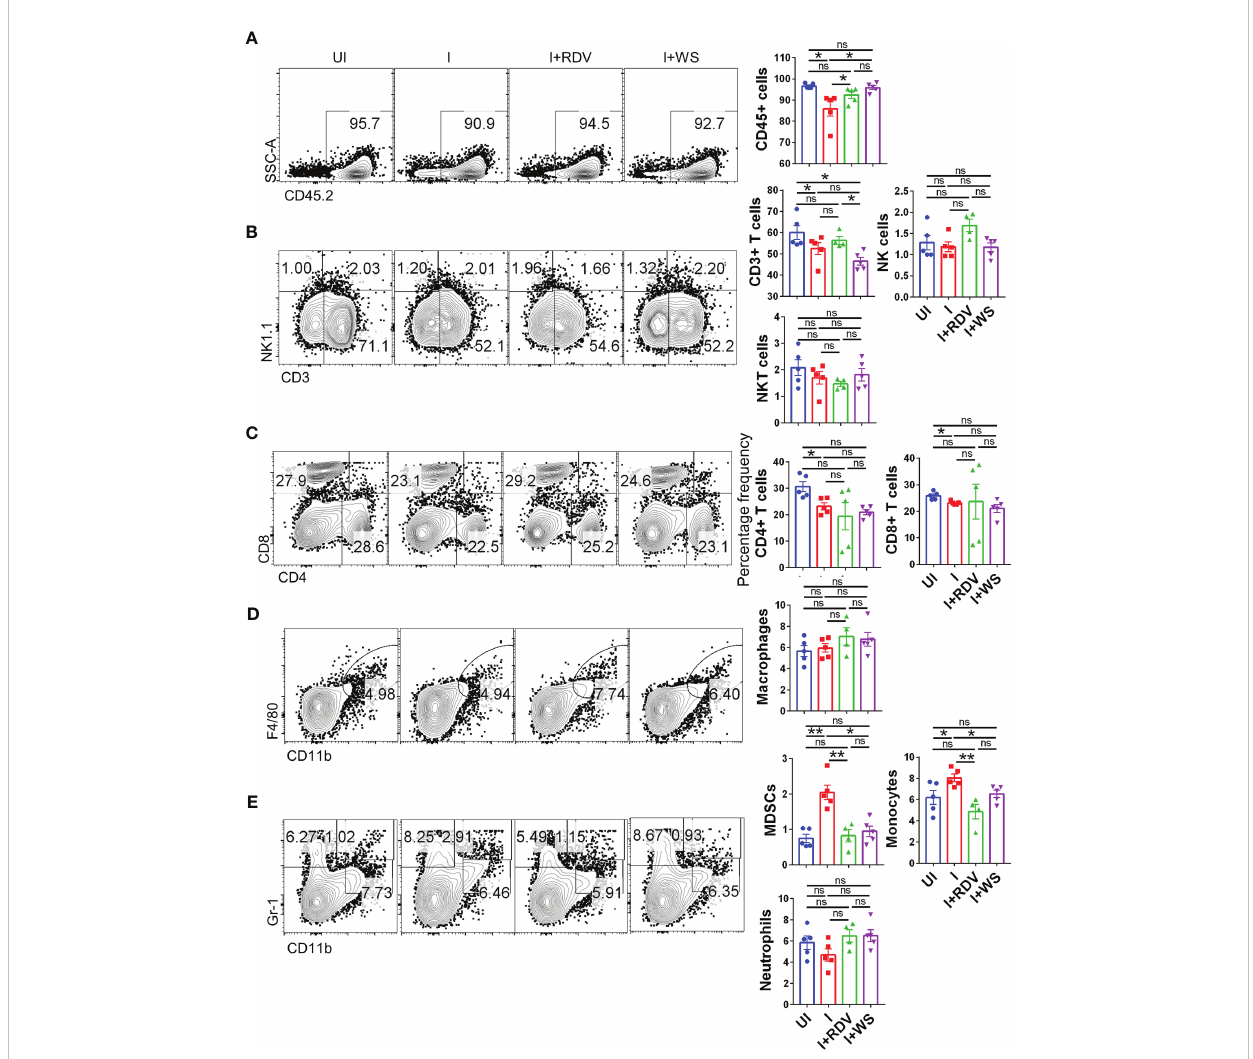
FIGURE 7 Changes in the major immune populations of infected hACE2 mice with or without treatment. Flow cytometry-based quantitation was done to evaluate changes in the major immune population in the lymph nodes of sacri fi ced animals at 6 dpi. The % age frequency was plotted as bar graph along with the representative contour plot (A) CD45+ population (B) CD3+ T lymphocytes, NK cells and NKT cells (C) CD4+ T helper cells and CD8 + T cytotoxic cells (D) Macrophages (E) Monocytes, neutrophils and MDSCs population. For each experiment N=5. One way-Anova using non- parametric Kruskal-Wallis test for multiple comparisons. *P < 0.05, **P <